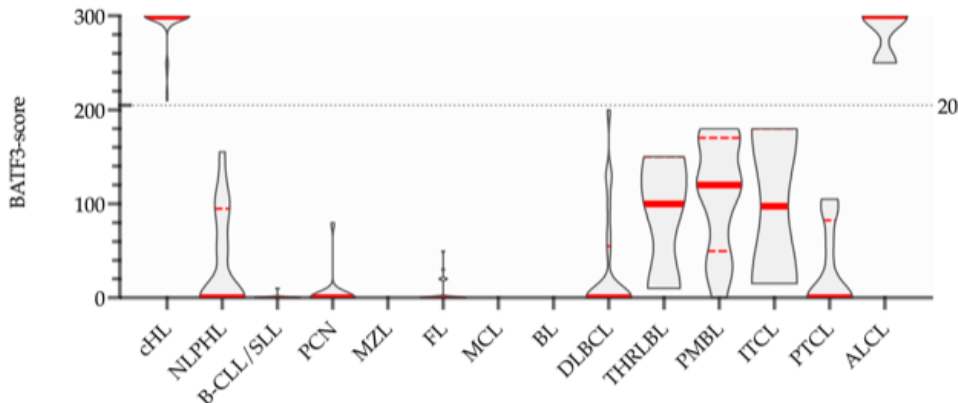
Figure 2. Truncated violin plots of BATF3-scores. Samples from CHL and ALCL showed constitu- tively high BATF3-scores, which could be clearly differentiated from those of the other lymphoma entities. An apparent threshold of 205 is indicated. Median ( — ) and Quartiles ( --- ) are highlighted.